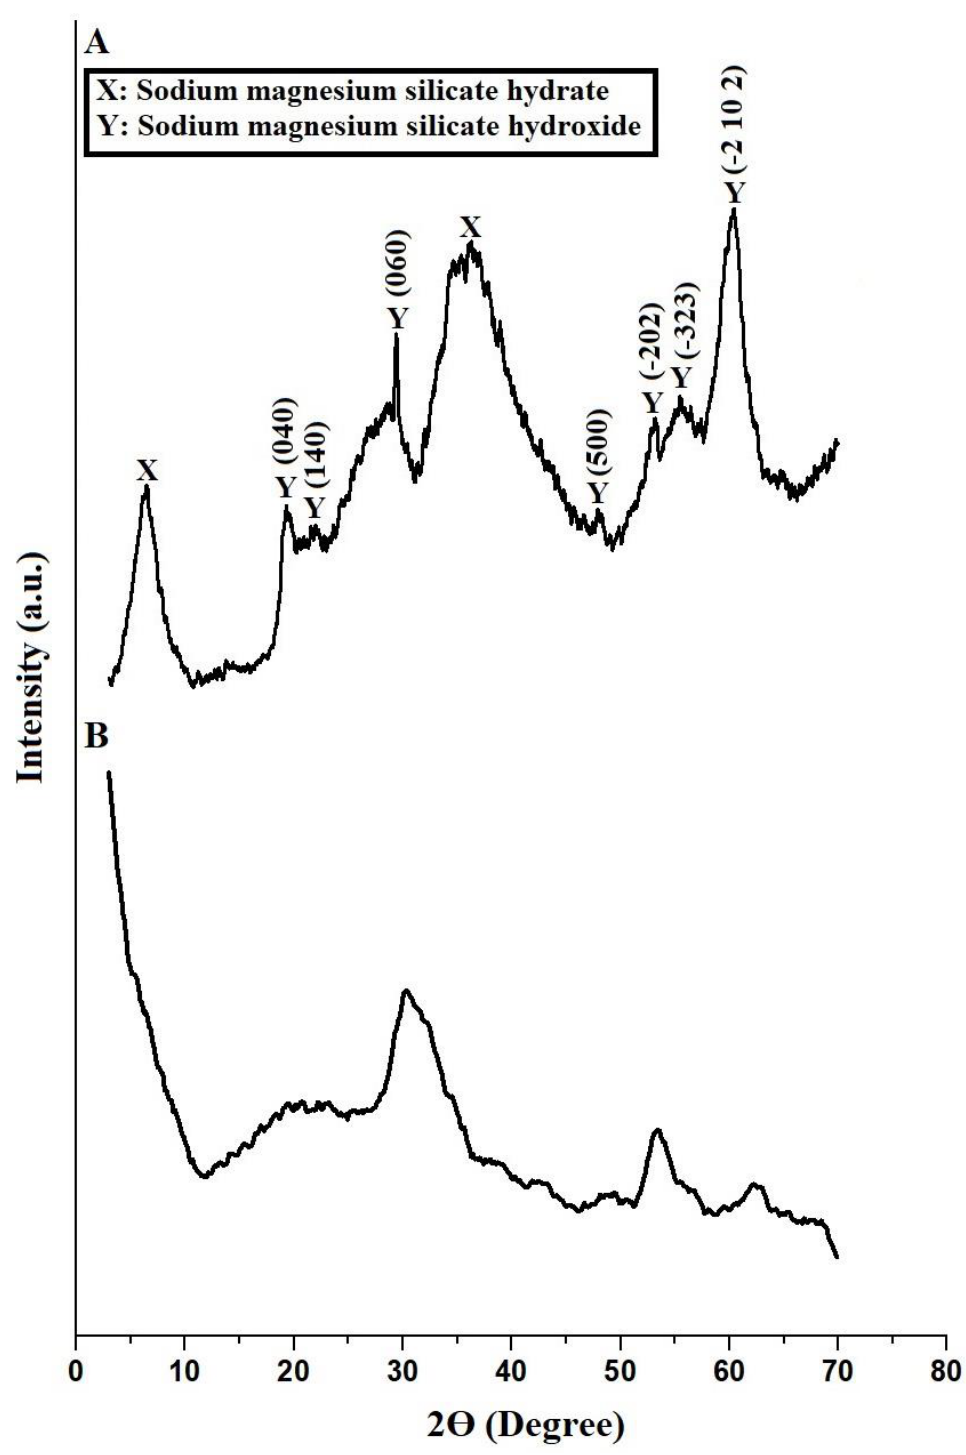
Figure 1. The XRD patterns of the F1 (nanostructures) ( A ) and F1S (nanocomposites) ( B ) samples. The EDX patterns of the F1 and F1S products are depicted in Figure 2A,B, respec- tively. Furthermore, the results show that the F1 sample is composed of O, Na, Mg, and Si with weight percentages equal to 38.59%, 5.95%, 16.60%, and 38.86%, respectively, and the F1S sample is composed of C, N, O, Na, Mg, and Si with weight